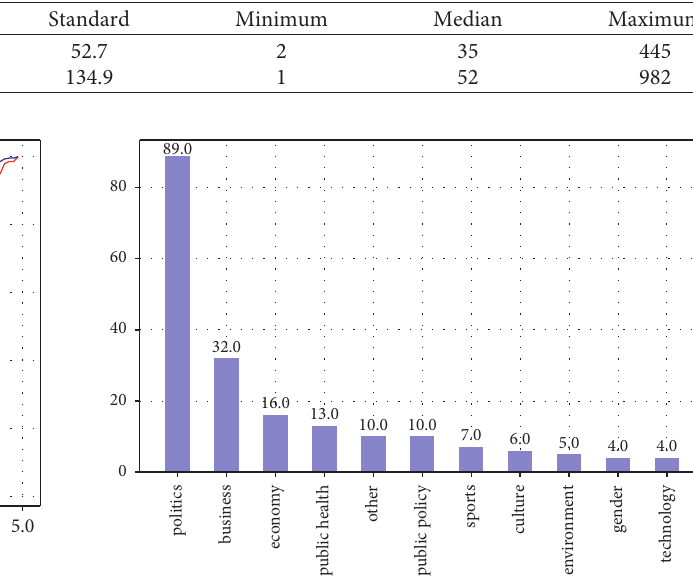
Figure 3: Distribution of 121 The New York Times reports’ topic.